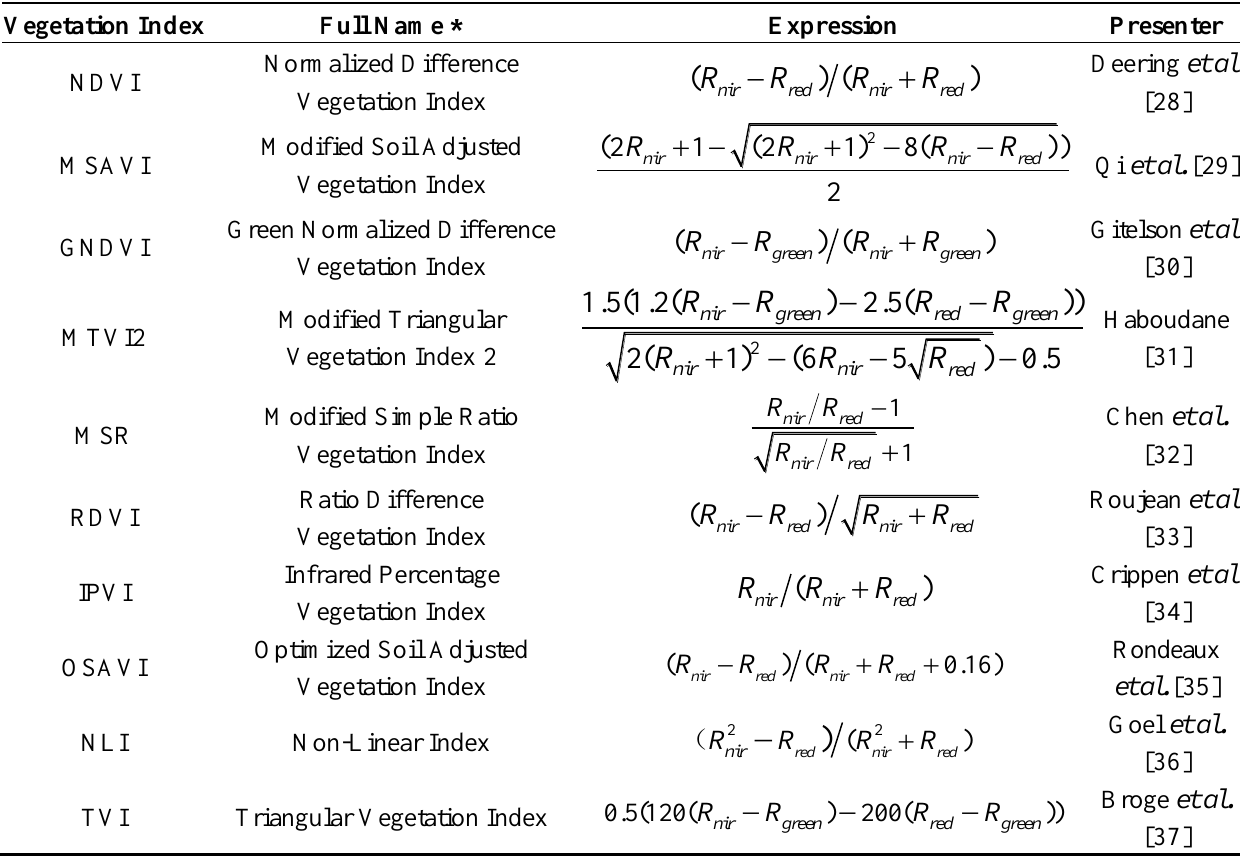
Table 4. Spectral vegetation index used in this study.